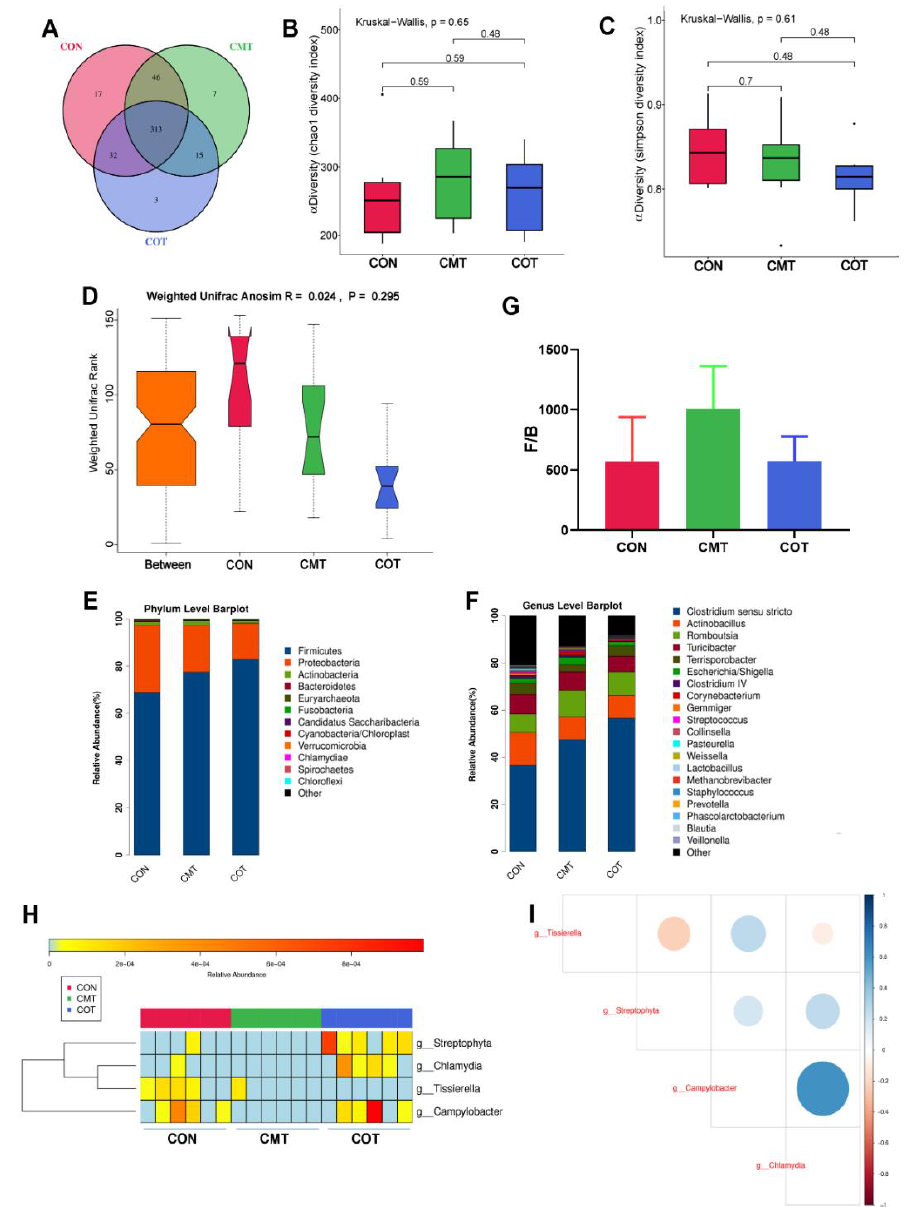
Figure 5. The high-throughput sequencing of 16S rRNA in ileum contents of piglets. ( A ) Venn analysis of bacterial OTUs composition among the three groups. ( B ) Chao1 index. ( C ) Simpson index. ( D ) ANOSIM, analyses of similarities among the three groups of samples. ( E ) Proportional taxonomic assignments at the phylum level from the three groups. ( F ) Proportional taxonomic assignments at the genus level from three groups. ( G ) The ratio of F/B among the three groups. ( H ) Heatmap cluster analysis of differential bacteria at genus level which has a contribution to group differences. ( I ) Spearman correlation analysis of the differential bacteria.